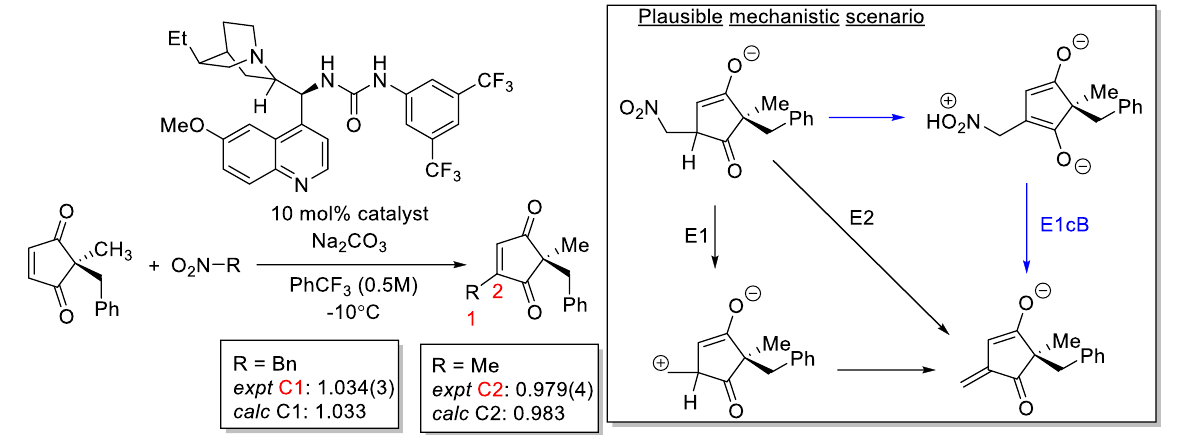
Figure 21. Urea-catalyzed desymmetrization [183]. All values are obtained from the work of Hirschi, Mukherjee, and co-workers [182] . “ Expt ” refers to the experimental 13 C KIE relative (please refer to the cited reference for details. Calc ” refers to the calculated 13 C KIE at IEFPCM/B3LYP/def2-SVP and the Biegeleisen – Mayer method [181].